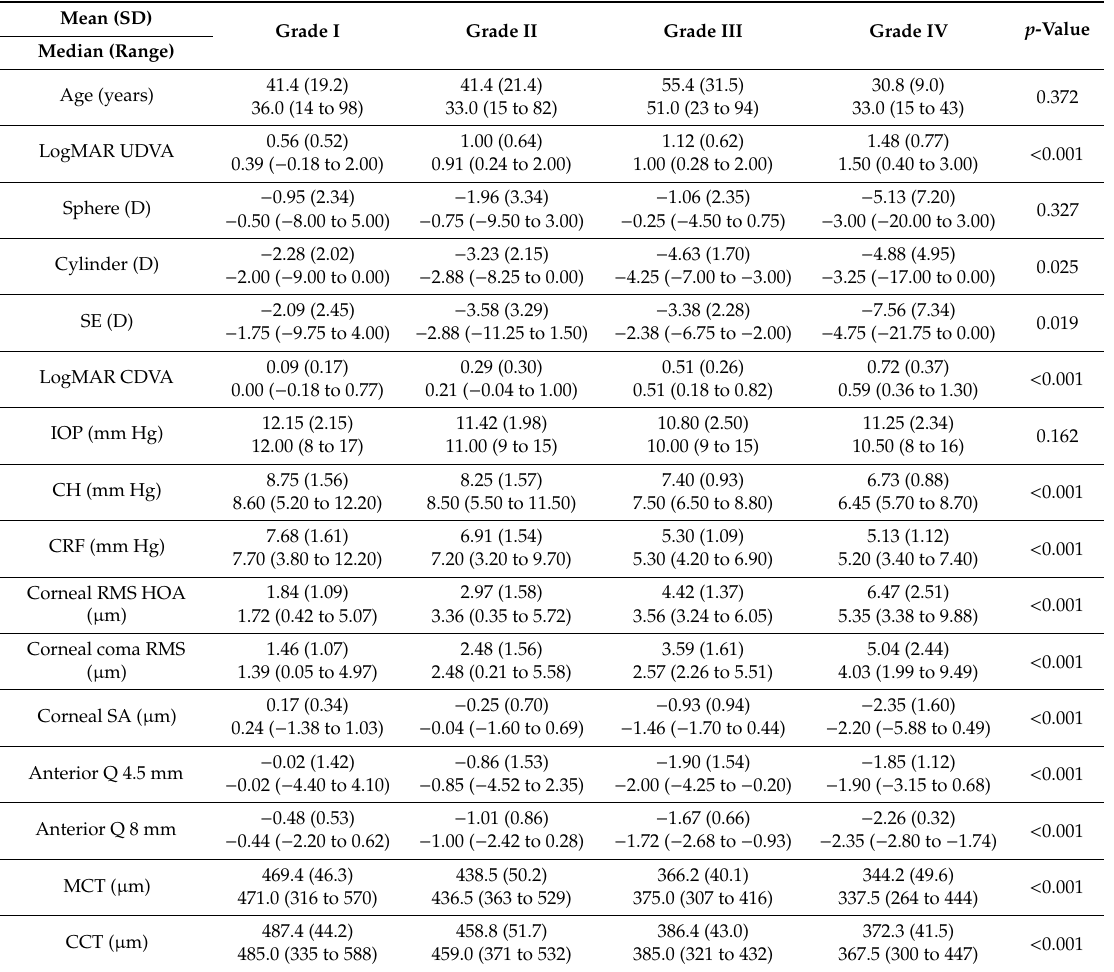
Table 1. Summary of the characteristics of the evaluated sample according to the level of severity of the disease defined using the RETICS (Thematic Network for Co-Operative Research in Health) grading system. Abbreviations: UDVA, uncorrected distance visual acuity; SE, spherical